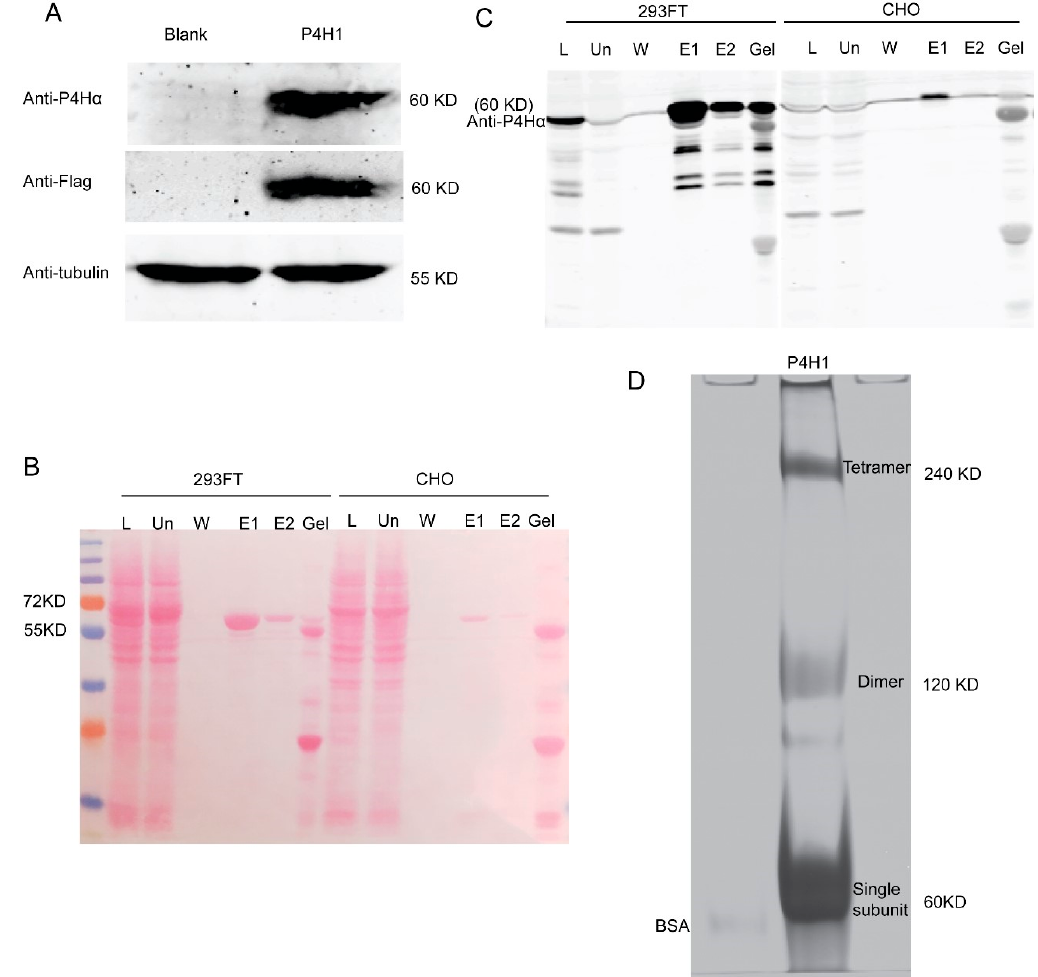
Figure 1. C-P4H1 is expressed and purified from HEK-293FT cells. ( A ) Expression of C-P4H1 was analyzed by western blot with anti-P4H1 α and anti-flag antibody. Cell lysates were collected from control and 293 FT cells transfected with P4HA1 and P4HB constructs. ( B ) Ponceau staining showed the expression and purification of C-P4H1 from 293 FT cells and CHO cells. The letters indicate: L (Total cell lysates with HGLB), Un (unbinding samples after cell lysates incubated with M2 gel), W (The last time washed sample in NET2), E1 (The first time elution sample in 0.25 µg/µL 3× Flag), E2 (The second time elution sample in 0.25 µg/µL 3× Flag), Gel (The remaining sample on M2 gel after elution). ( C ) Western blot analysis of C-P4H1 expression and purification with anti-P4H α . ( D ) Purified P4H1 samples was analyzed by 8% Native PAGE gel with Coomassie Blue staining; BSA was included as a control.